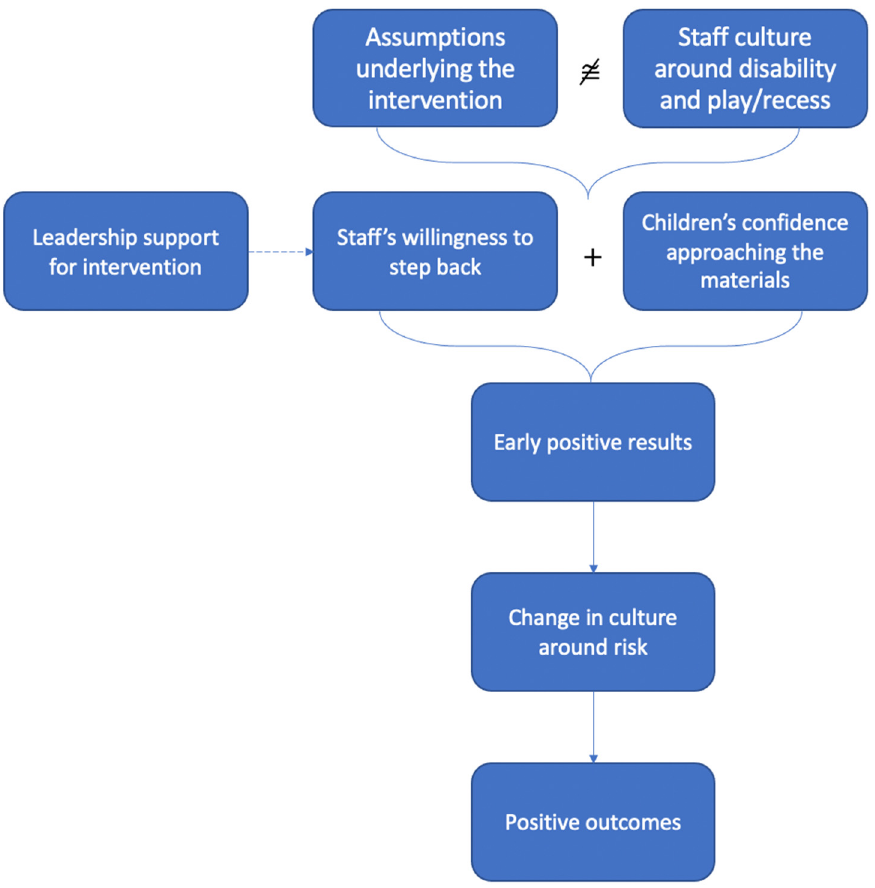
Figure 4. Proposed relationship among aspects of staff culture, assumptions underlying the inter- vention, and the intervention at School B. ≅ refers to incongruence.